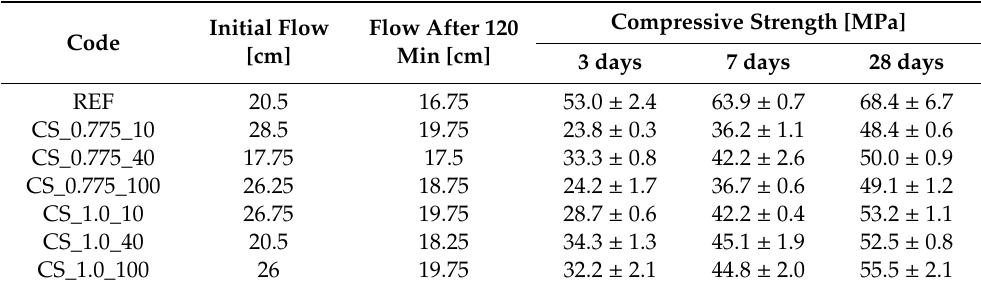
Table 4. Characterization of mortar: initial flow, flow after 120 min, mortar compressive strength after 3, 7 and 28 days (n = 6), Series